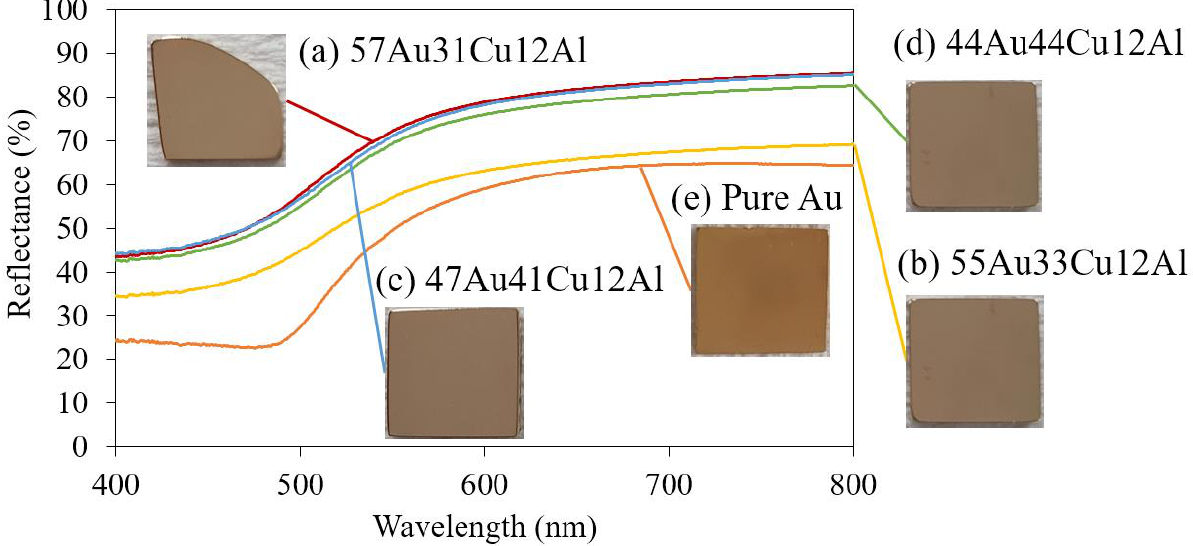
Figure 7. Reflectance analysis results of ( a ) 57Au31Cu12Al, ( b ) 55Au33Cu12Al, ( c ) 47Au41Cu12Al, and ( d ) 44Au44Cu12Al alloys as well as the ( e ) pure Au.